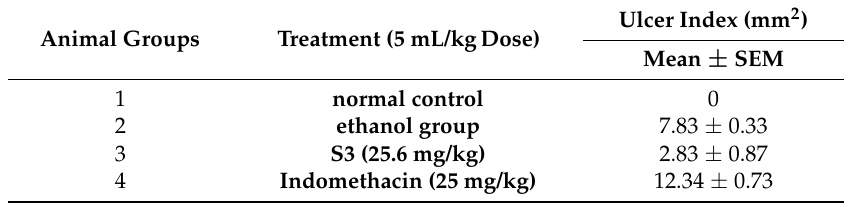
Table 4. Ulcer index of compound S3 compared with standard drug indomethacin.